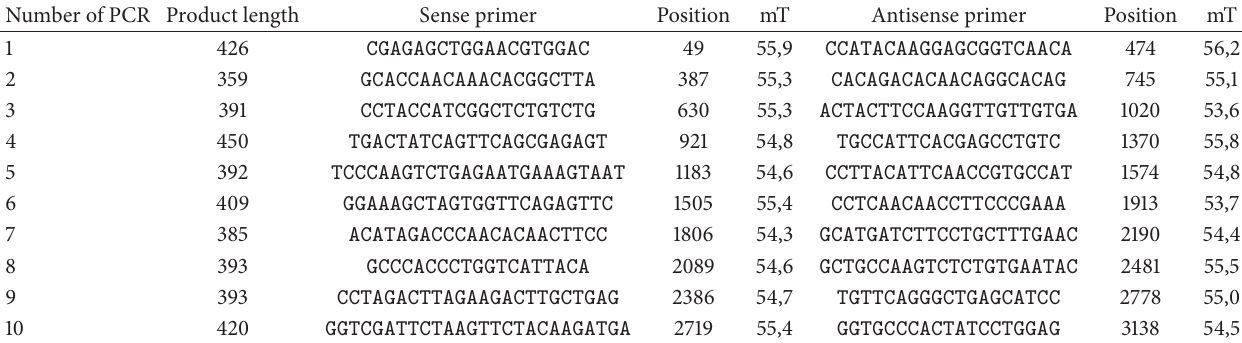
Figure 2: Flow cytometric analysis of expression of CD45, CD2, and CD25 on CD117+ neoplastic mast cells on bone marrow blood at diagnosis. Table 1: Primer positions according to the reference KIT sequence ENST00000288135 used for sequencing of KIT gene. mT: melting